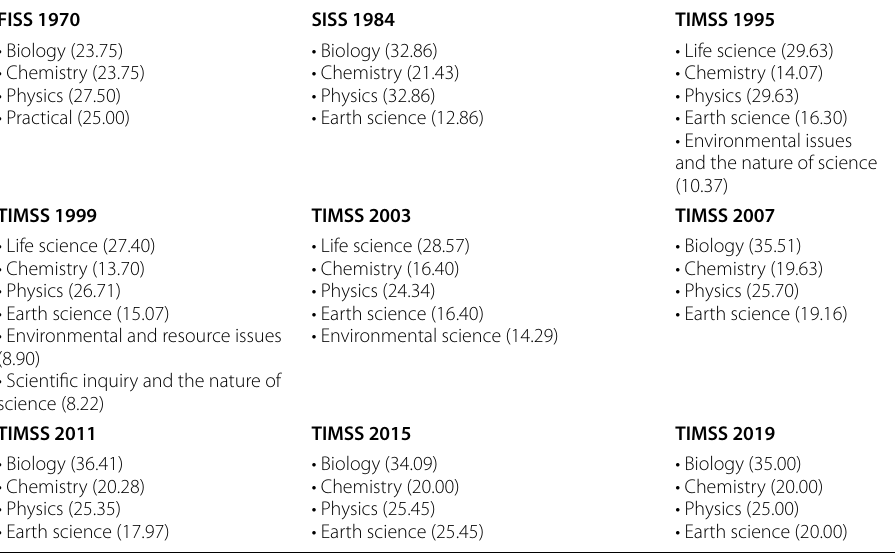
The percentage of items is shown in